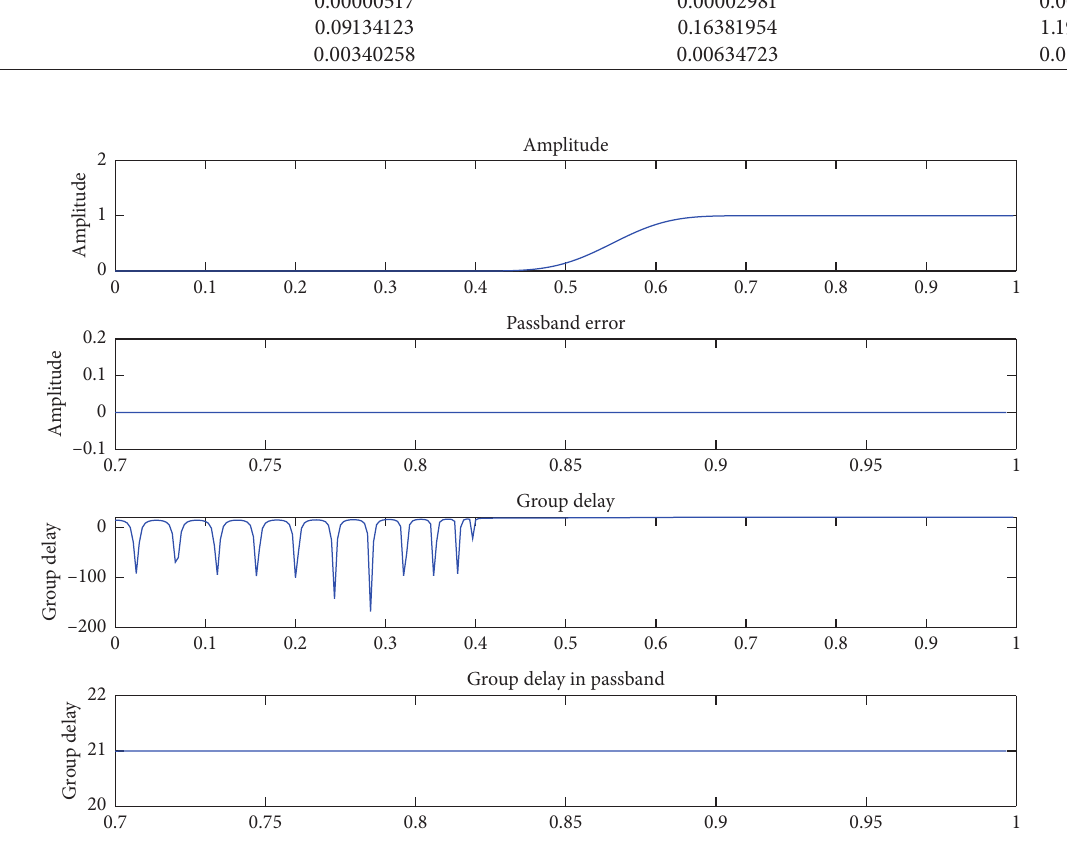
Figure 3: Performance of original FIR filter for example